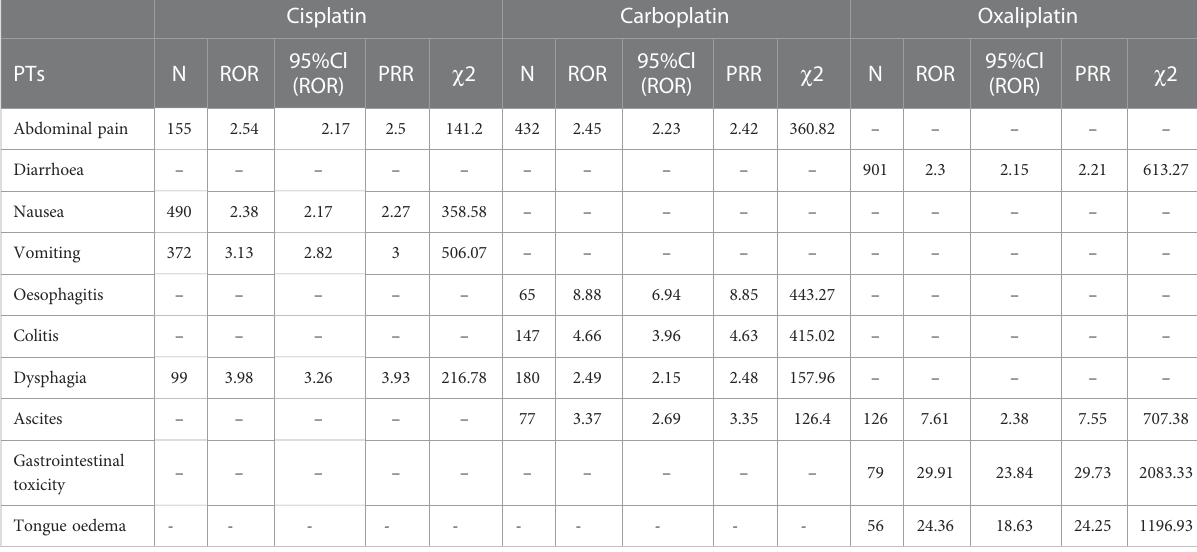
TABLE 6 Gastrointestinal system disorder-related adverse events of Cisplatin, Carboplatin and